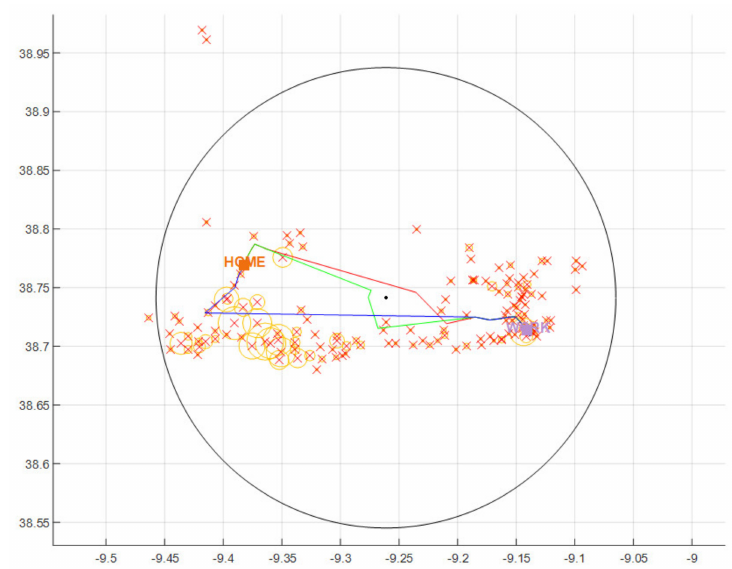
Figure 16. An example of applying the commuting-radius based noise filtering from which the visited cell towers located within the commuting-radius scope are taken further for the route inference but those located outside the scope are considered as noise and then